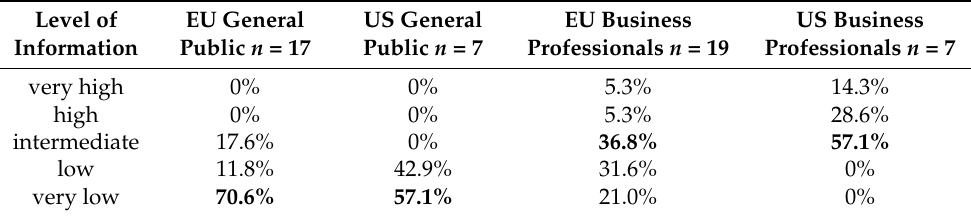
Table 4. Comparison of the level of information on TTIP negotiations and content of TTIP agreement in the EU and US general public and business professionals.